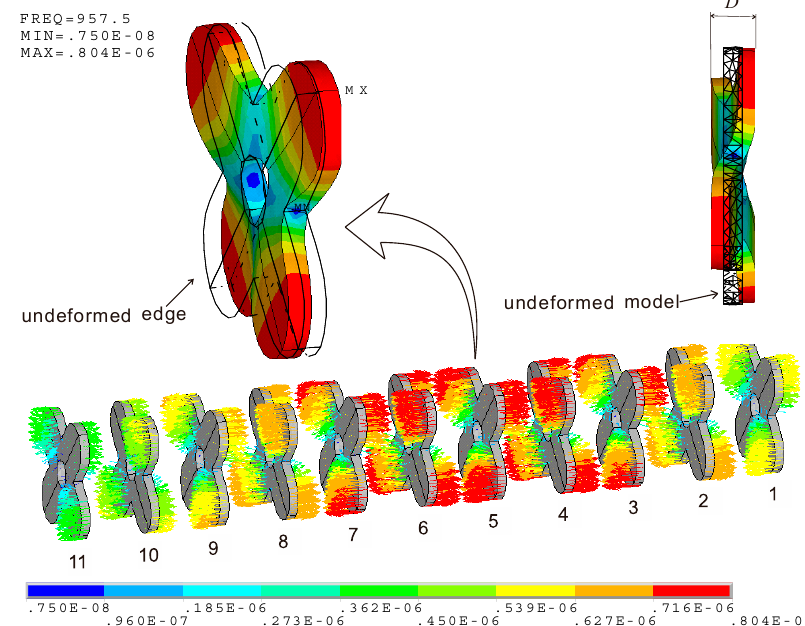
Figure 9. Vector illustration of flexural vibration at 957.5 Hz (cross-beams).